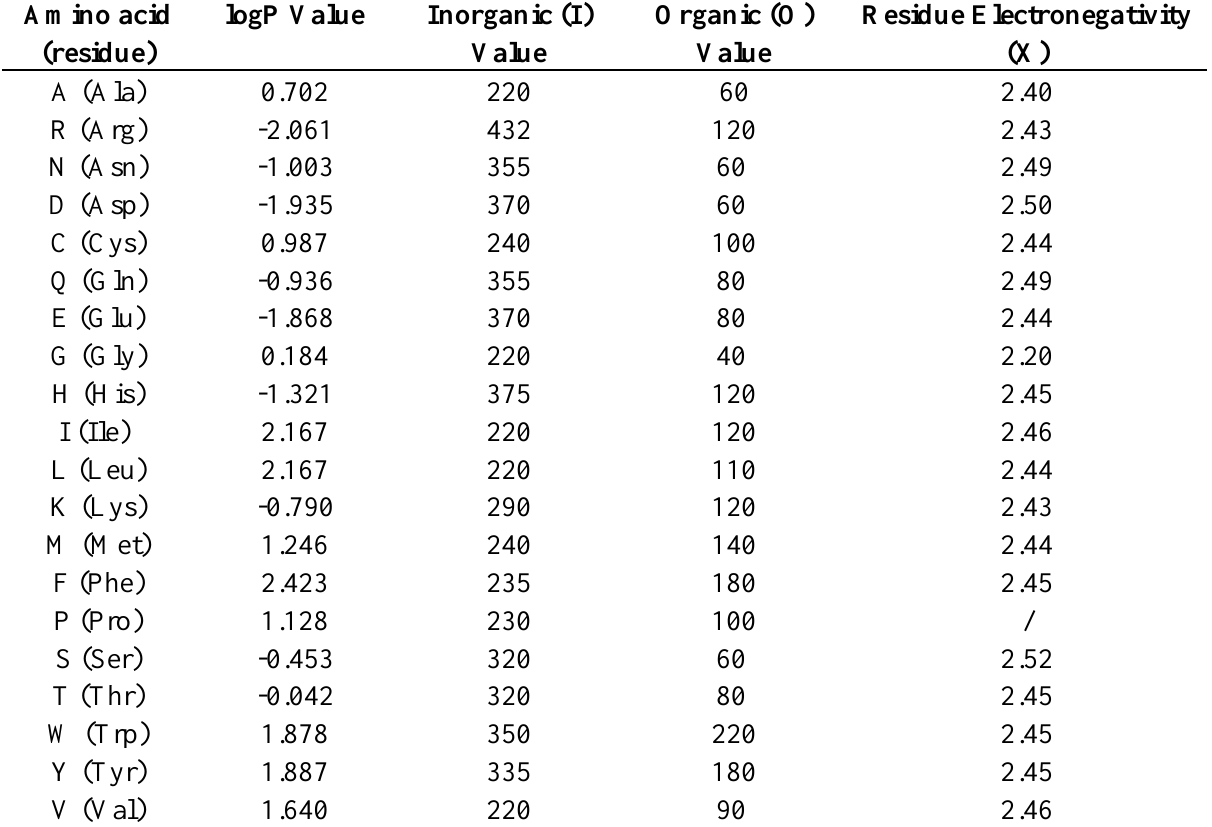
Table 4. Amino acid residue logP, amino acid inorganic property and organic property values and residue electronegativity